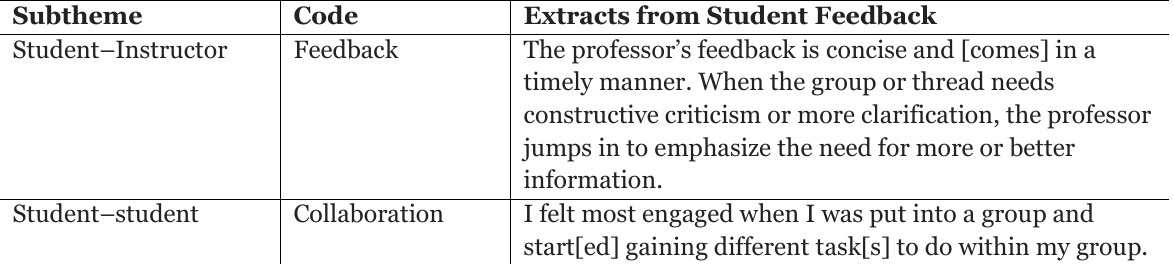
Sample Extracts of Student Comments